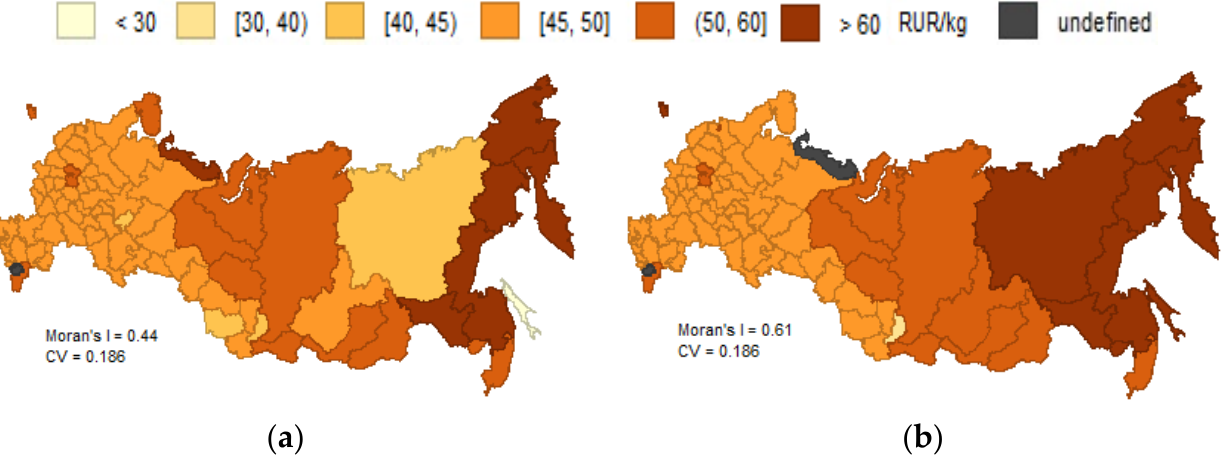
Figure 7. Spatial distribution of Sugar price, 10 June 2021 ( a ) and 7 September 2021 ( b ). All regions, for which the data are not available for these dates, are marked as “undefined”.